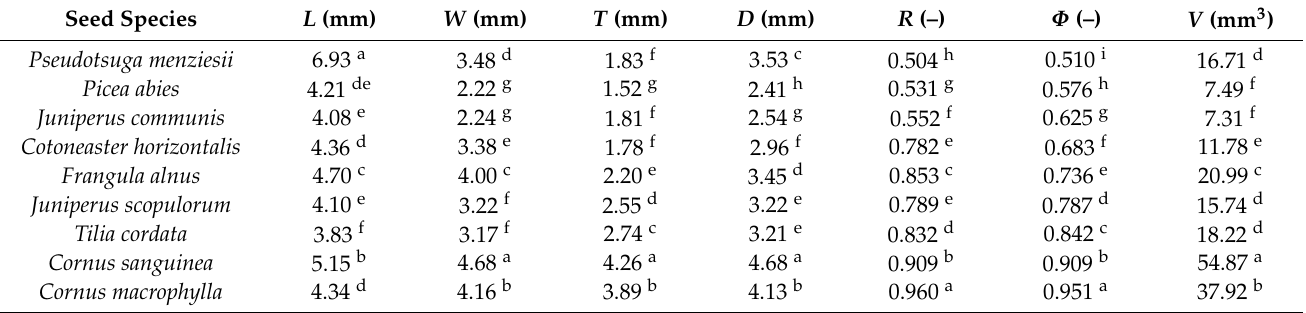
Table 2. Mean values of the physical properties of seeds and the significance of